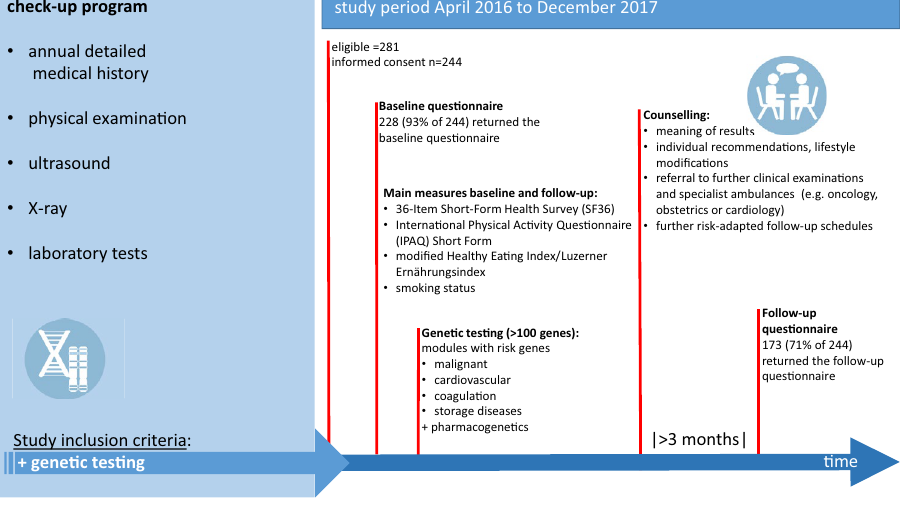
Figure 1. Study setting and participant flow